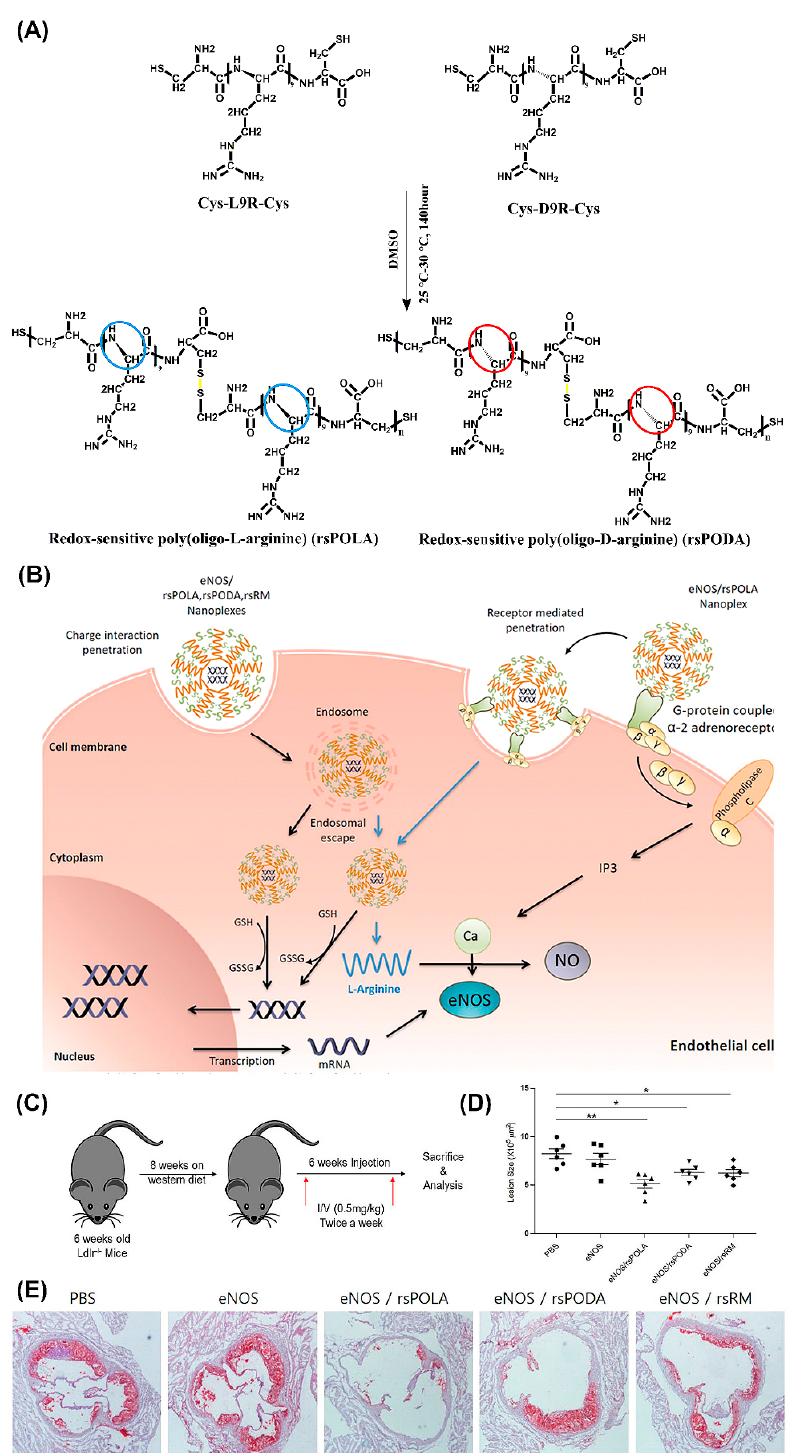
Figure 10. Schematic illustration of ( A ) chemical one-step synthesis of redox-sensitive poly(oligo- arginines) (rsPOLA), ( B ) targeted gene delivery of rsPOLA peptiplexes into endothelial cells, and ( C ) experimental design of evaluating peptiplexes anti-inflammatory and anti-atherogenic potency in Ldlr − / − atherosclerotic mice. ( D ) Mean lesion size of sinus aorta after treatments (n = 6 animals per group). ( E ) Representative images of Oil Red O-positive atherosclerotic lesion after treatment ( n = 6). Reproduced from [139], with permission. Copyright: 2017 Elsevier.